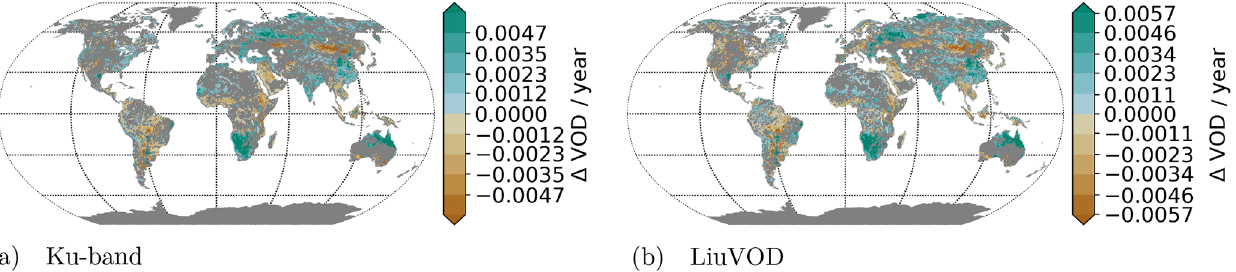
Figure 14. Trends between 1993 and 2012 of Ku-band VODCA (a) and VOD_Liu (b) . Non-significant trends are not displayed; the trends are calculated by Theil–Sen regression using yearly mean